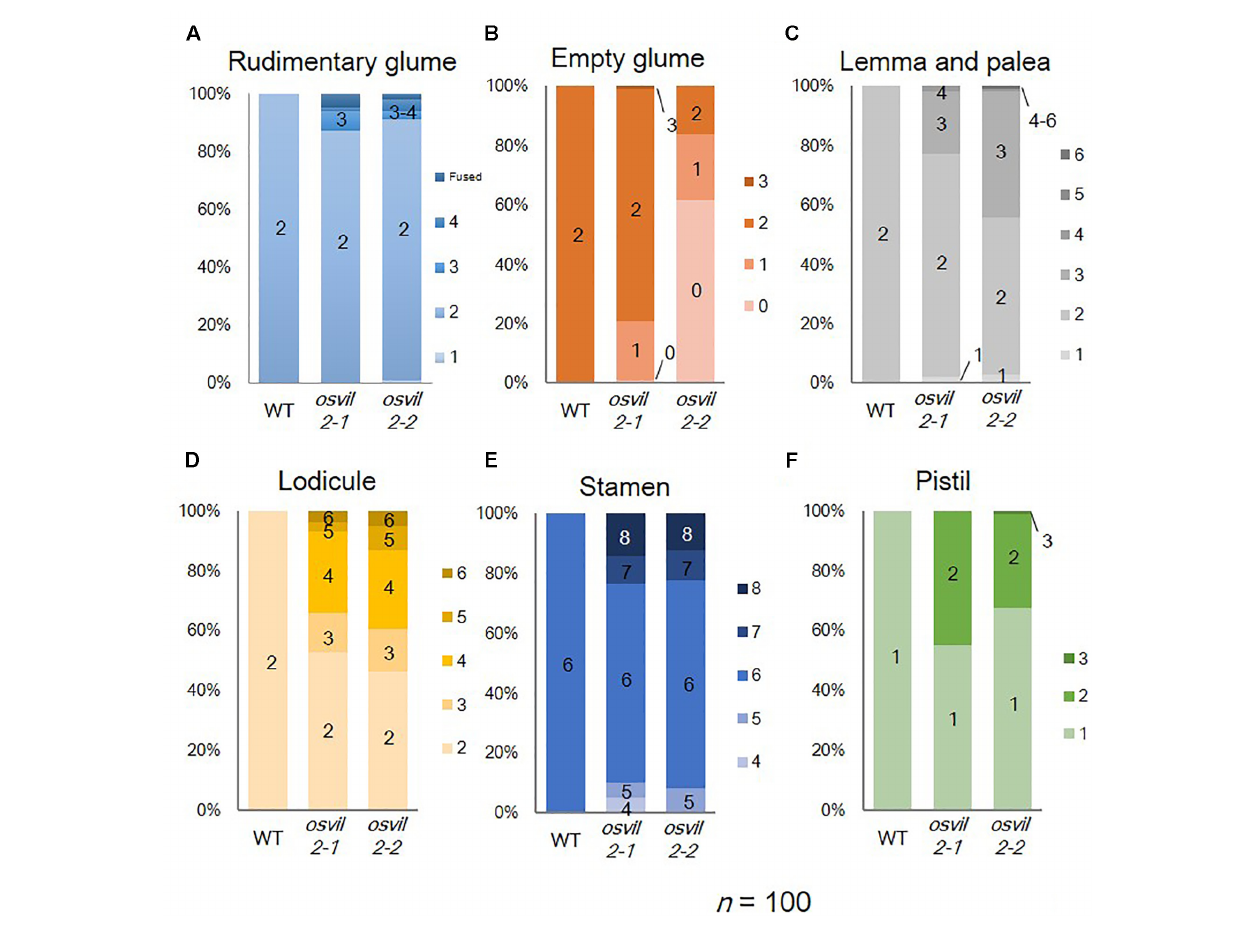
FIGURE 2 | Floral organ numbers in WT, osvil2-1 , and osvil2-2 spikelets. (A) Rudimentary glumes; (B) empty glumes; (C) lemma and palea; (D) lodicules; (E) stamens; (F)